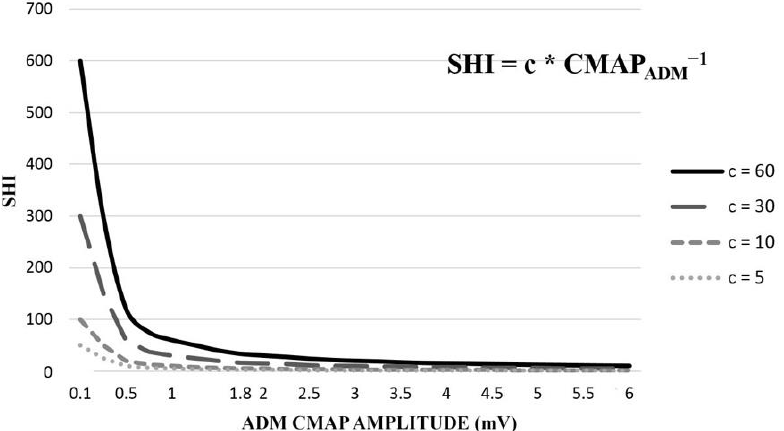
Figure 4. A simulation of SHI values for different ADM CMAP amplitudes. The different lines reflect different values of c (where c is the product of the CMAP amplitudes of APB and FDI) .